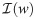
Total information flow as a function of time—The prices time series.Behavior of the total information flow I(w)
Eq (6) at different time differences δ, when computed for daily prices rather than returns. Each time window w is 500 days long. The date associated with each w is the middle of the time window considered. The x-axis tick marks correspond to the dates of the first of March each year. No meaningful information can be obtained from this analysis in contrast to the results presented in Fig 1.